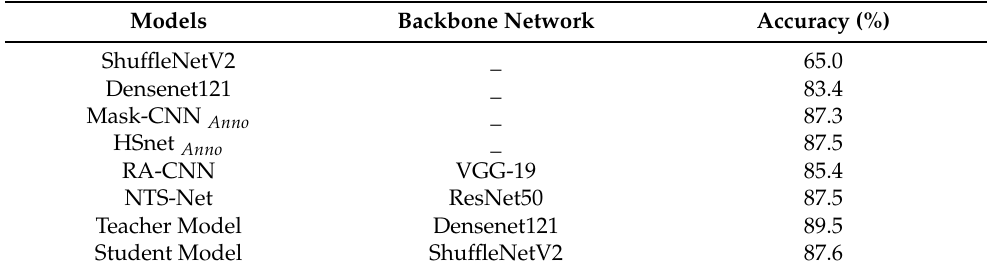
Table 4. Comparison of the accuracy results of different models in the CUB-200-2011 dataset. Anno de- notes the strongly supervised learning method, i.e., using bounding boxes or component annotations during the training process.